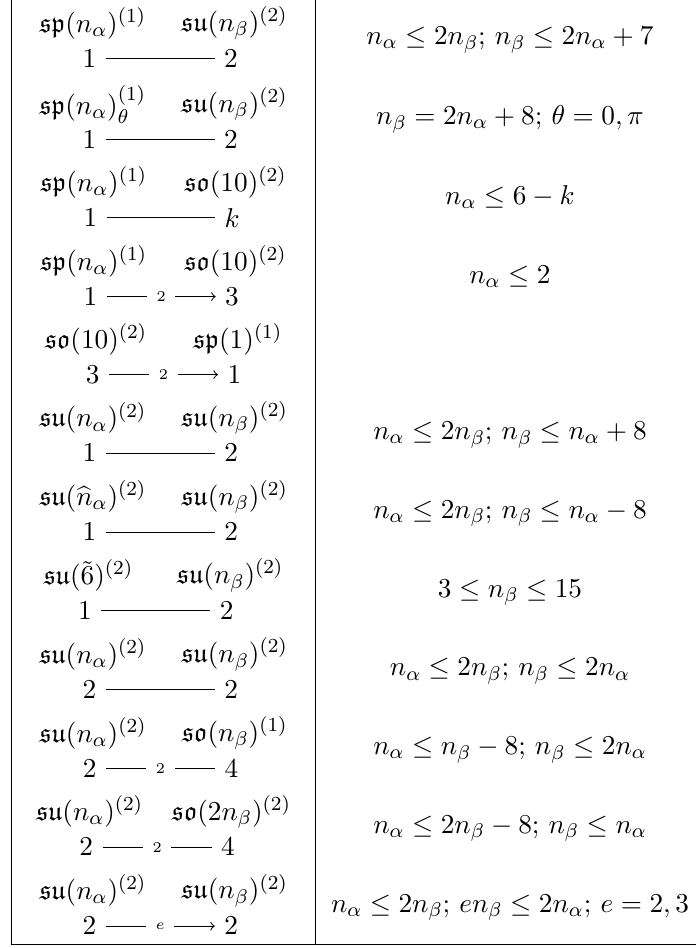
Table 4 . List of all the new combinations of KK theory building blocks that can arise by including new KK theory building blocks arising from twists of the first